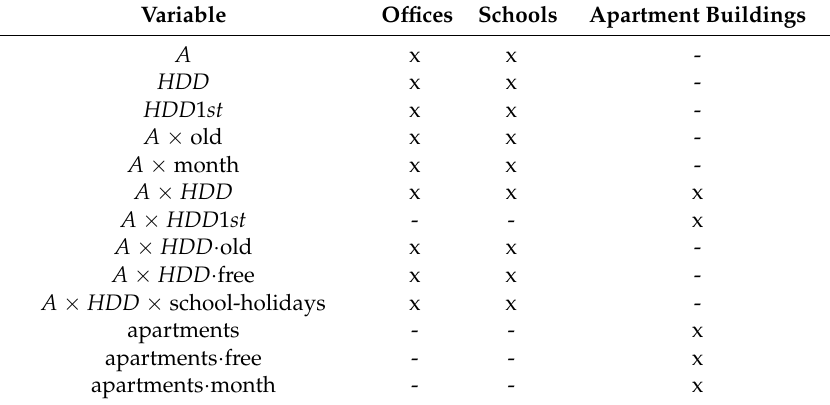
Table A4. Explanatory variables, models for hourly district heat